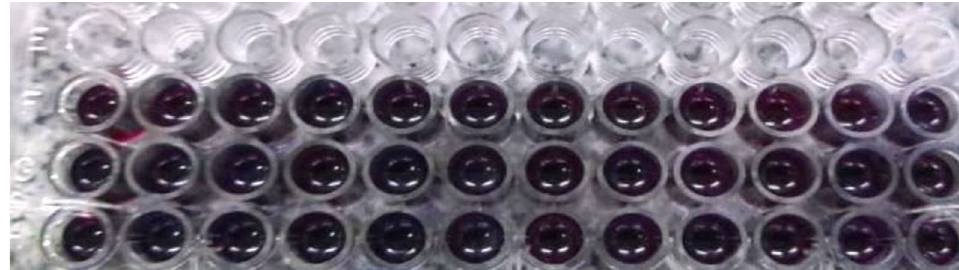
Fig. 1 MTT assay, well plate optical density indication for cell